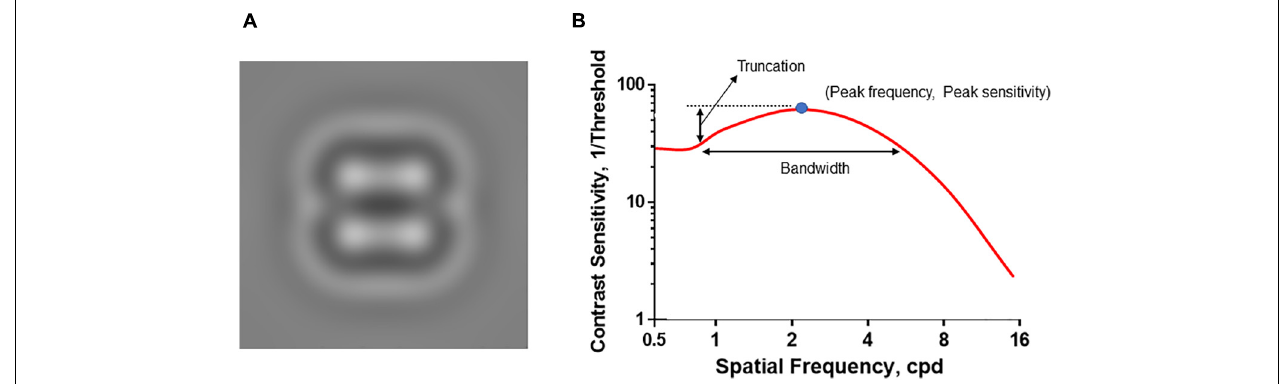
FIGURE 1 | Introduction of qCSF visual stimuli and CSF curve. (A) The representative visual stimuli sample. The bandpass-filtered digits were used as the visual stimuli to measure the contrast sensitivity thresholds. (B) The CSF curve. Peak sensitivity, peak gain; Peak frequency, the spatial frequency corresponding to peak gain; Bandwidth, the function’s full-width at half peak sensitivity; Truncation, the distance between the peak sensitivity and